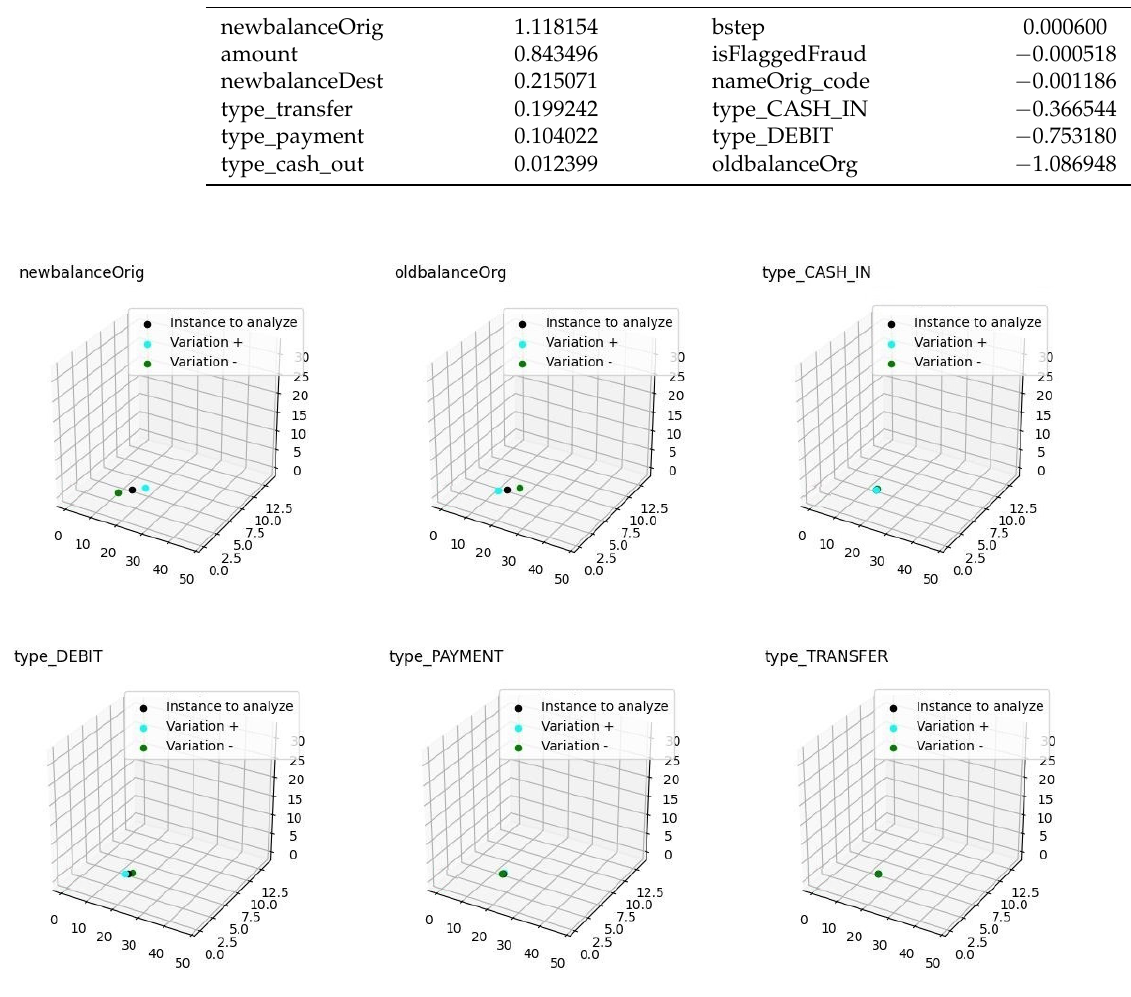
Figure 5. Representation for one non-fraud transaction of how small variations for each feature in real space affect in the latent space with MIFF filter in the PaySim